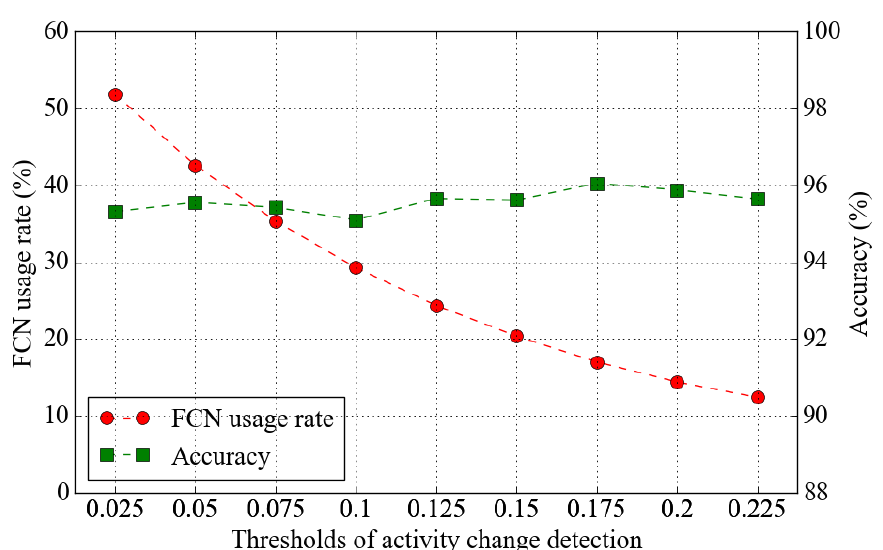
Figure 6. FCN usage rate and accuracy of activity recognition according to the thresholds of activity